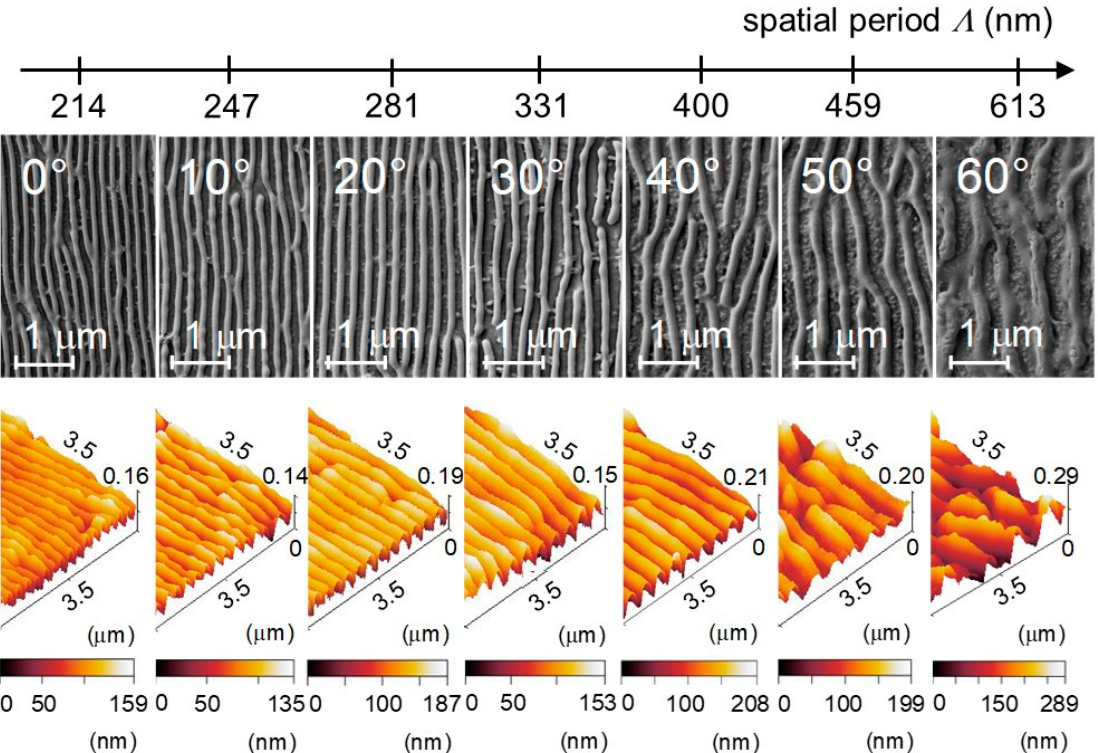
Figure 2. Variation of the spatial period of LIPSS on PET as a function of the angle of incidence θ = 0 ◦ , 10 ◦ , 20 ◦ , 30 ◦ , 40 ◦ , 50 ◦ , and 60 ◦ of the linearly polarized laser beam at a constant fluence of about Φ = 5.7–6.2 mJ/cm 2 , with N = 6000 pulses: ( top ) top-view scanning electron microscopy (SEM) images; ( bottom ) atomic force microscopy (AFM) topography images of the corresponding structures. Table 1. Spatial period Λ , height of the ripples h ± standard deviations for LIPSS on PET formed